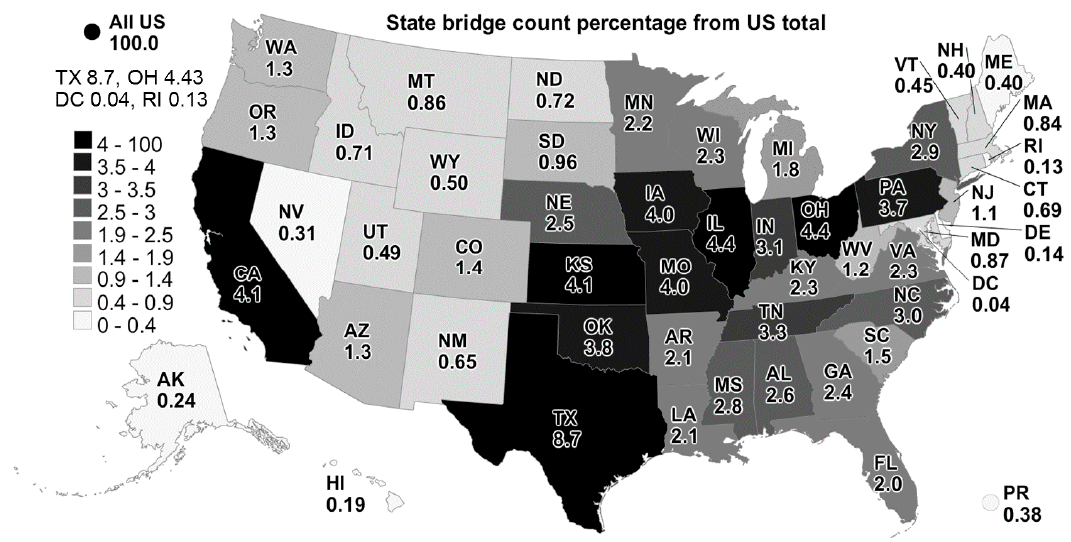
Figure 1. Percentage distribution of state bridge counts from U.S. total.